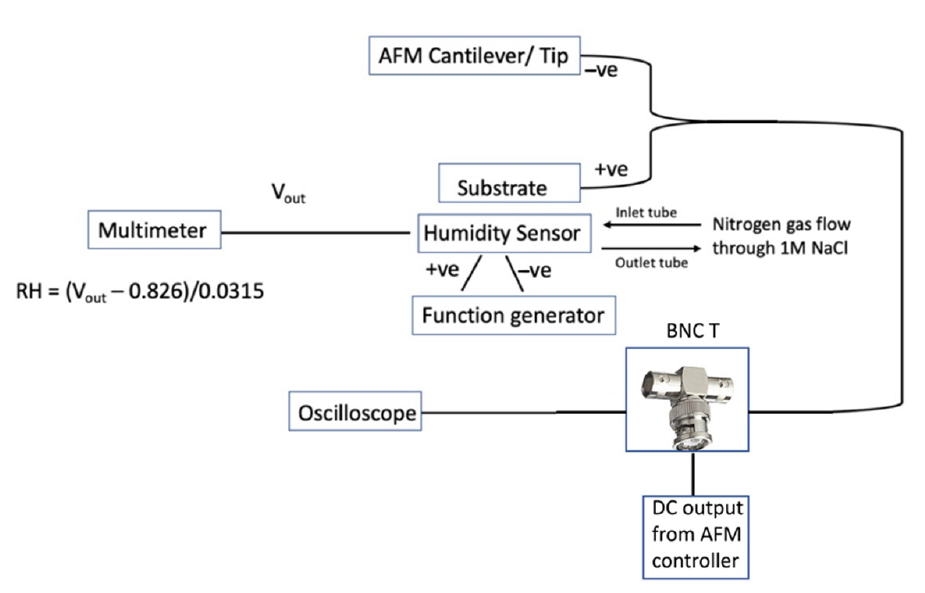
Figure A1. The schematic representation of the external circuitry provided to apply bias to the AFM tip and substrate. BNC: Bayonet Neill − Concelman coaxial cable connector; RH: Relative Humidity.